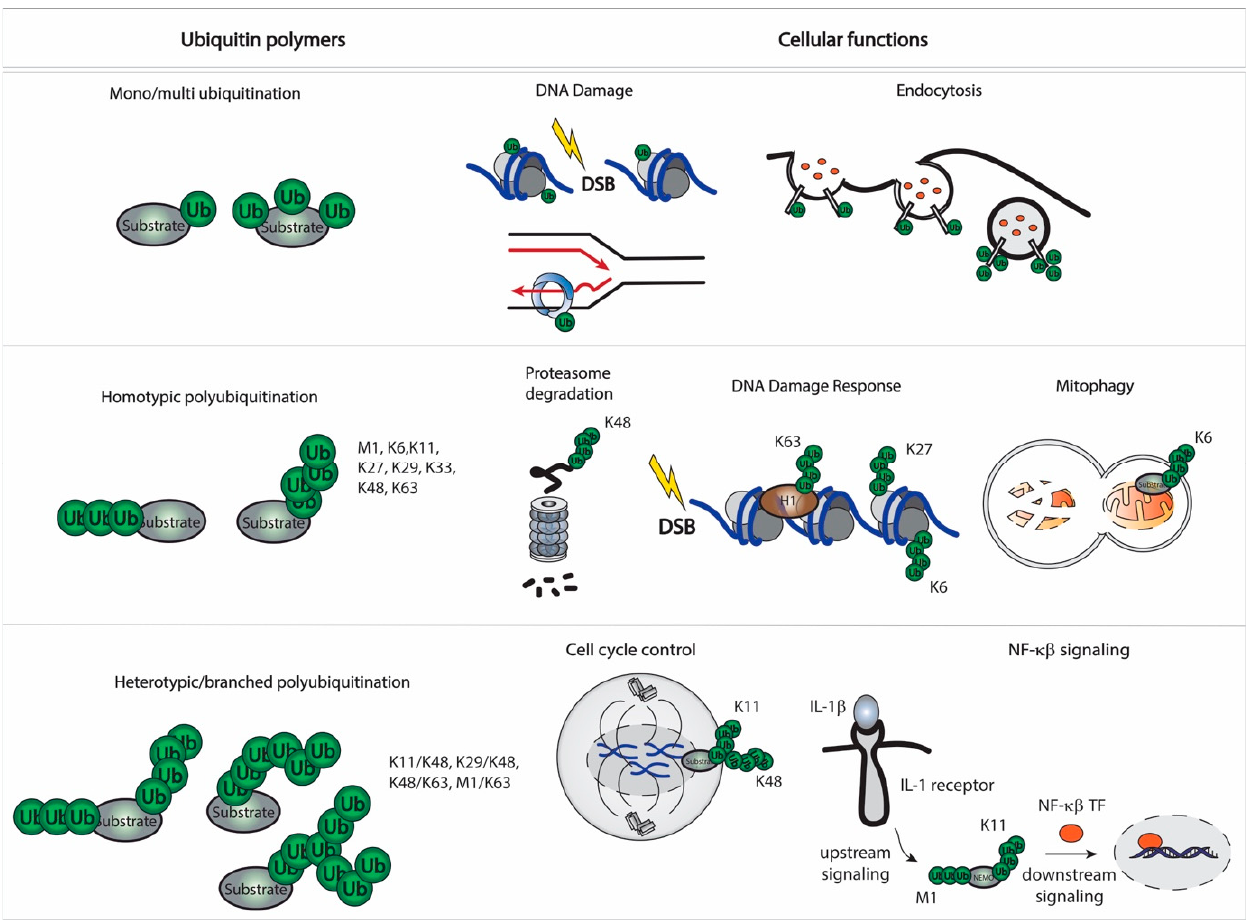
Figure 4. Ubiquitination polymers. Ub moieties can modify proteins at one (mono ubiquitination) or several (multiple mono ubiquitination) Lys residues. Ub can form eight distinctive homotypic linkages, either through M1 (linear Ub chain) or 7 internal Lys residues (K6, K11, K27, K29, K33, K48, and K63 Ub chains). Additional complexity is achieved through the formation of heterotypic Ub chains, which contain multiple Ub linkages and adopt mixed or branched topology. Cellular functions associated to these ubiquitin polymers are displayed.